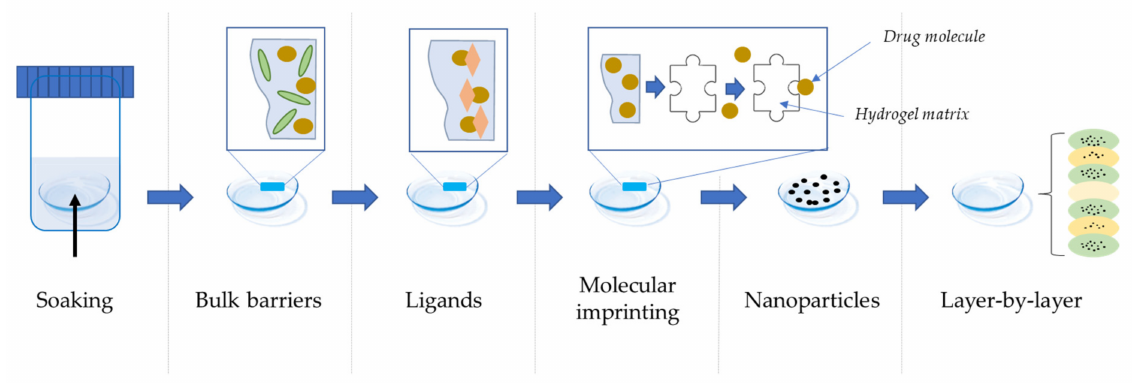
Figure 2. The diagram of strategies commonly used to improve drug release from drug-loaded SCLs